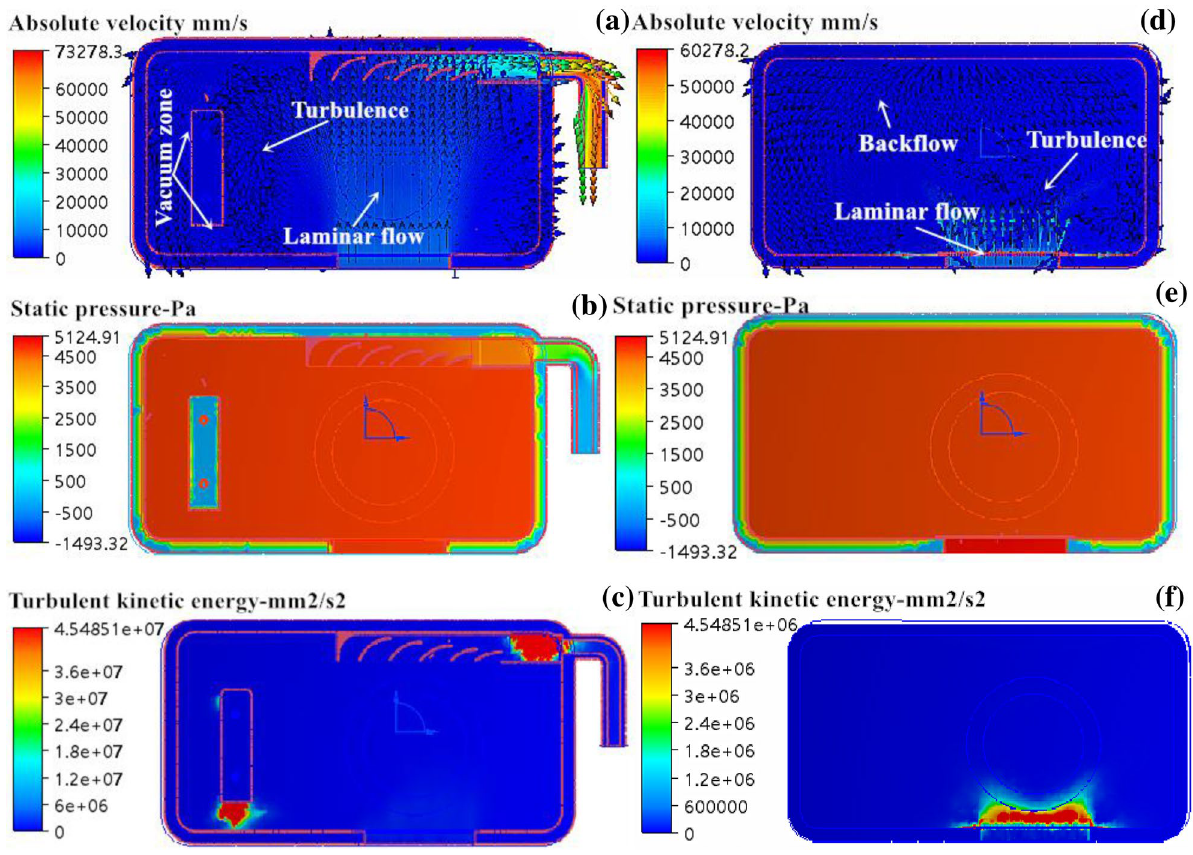
Figure 5. Simulation results of mold flow in forming cavity: ( a ) and ( d ) are velocity distribution diagrams; ( b ) and ( e ) pressure profiles; ( c ) and ( f ) turbulence Flow‑field analysis of the current forming cavity. Figure 5 shows a flow-field distribution diagram of the fluid flowing through the forming cavity. In Fig. 5a, the flow velocity distribution of nitrogen at the lower end of the forming cavity is shown. The current forming cavity had good connectivity and a high flow velocity at the outlet end. It had a measured flow velocity of 52.35 × 10 3 mm/s and a volume flow rate of 10.65 × 10 4 mm 3 /s. At the upper end of the powder cylinder, the layers of fluid flow interfered with each other, and the distribution was relatively disordered. The turbulent flow severely interfered with the laminar flow at the upper end of the form- ing cylinder, and the flowing vacuum zones on the left side and bottom end of the powder brush, as well as the end of the guide groove, were not conducive to fluid flow. This seriously affected the ability of the guide groove to discharge splashing particles and “solid smog”, and it easily led to defects in the formed parts. In Fig. 5d, the flow velocity distribution of nitrogen entering the forming cavity from the upper inlet end is shown. The severe